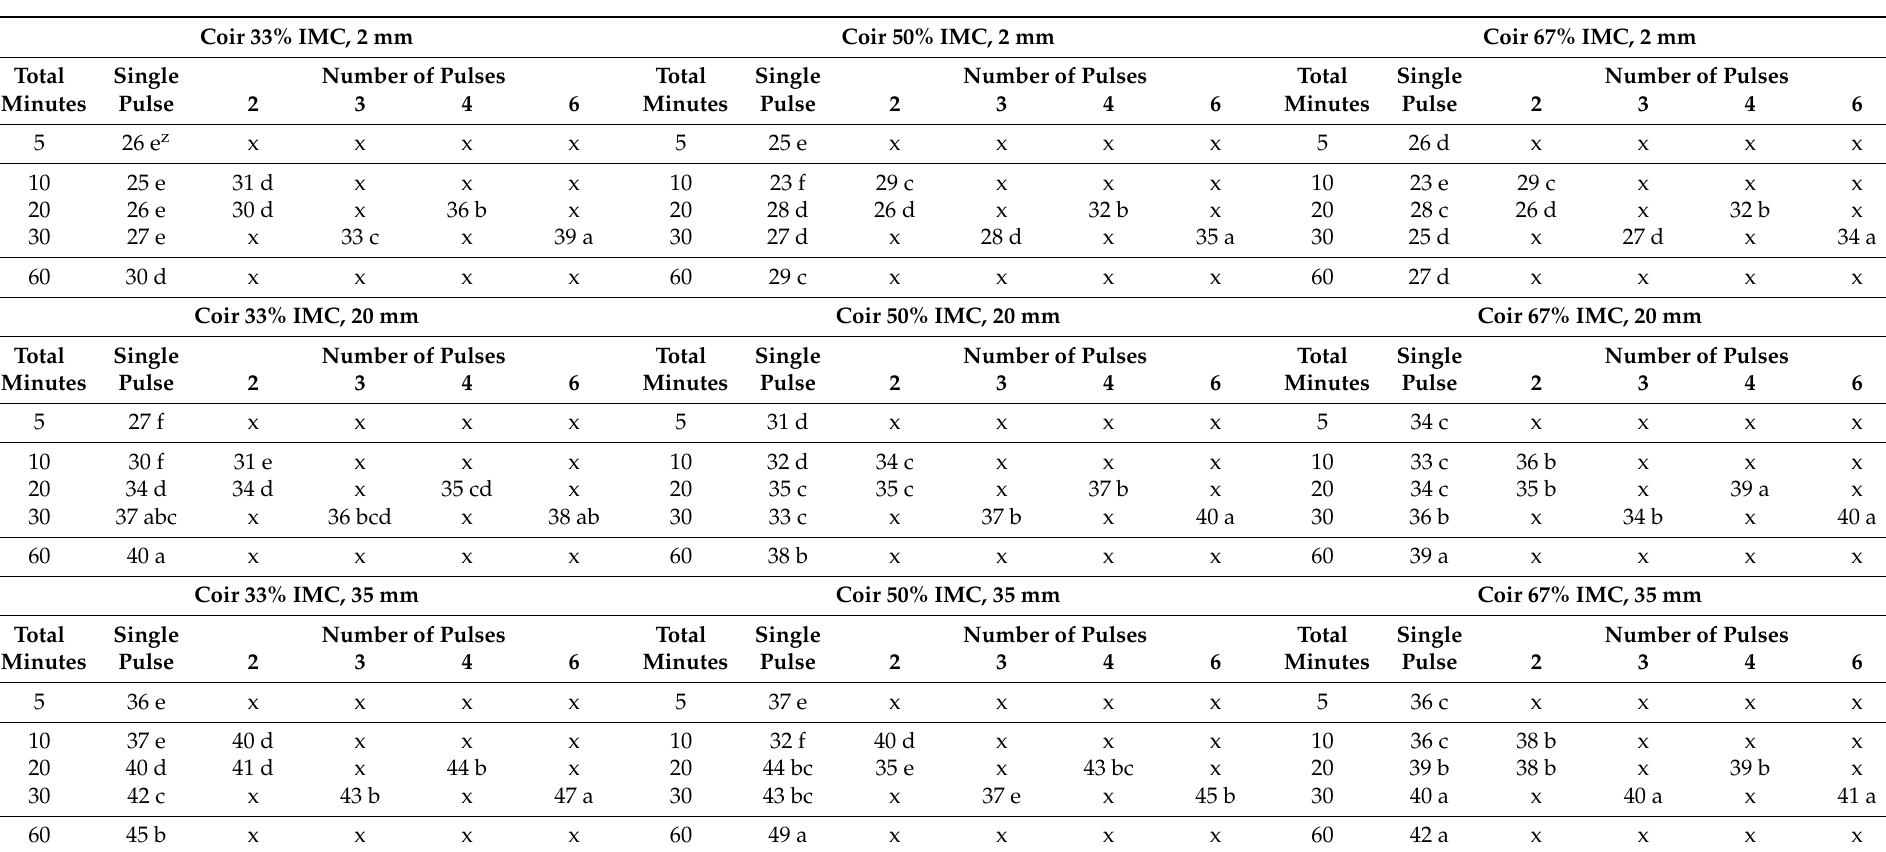
Table 2. Average water capture (% VWC) of coconut coir at three initial moisture contents (IMC) of 33%, 50%, and 67%, three irrigation water levels of 2 mm, 20 mm, and 35 mm, and at five irrigation pulse durations (by event total) per water